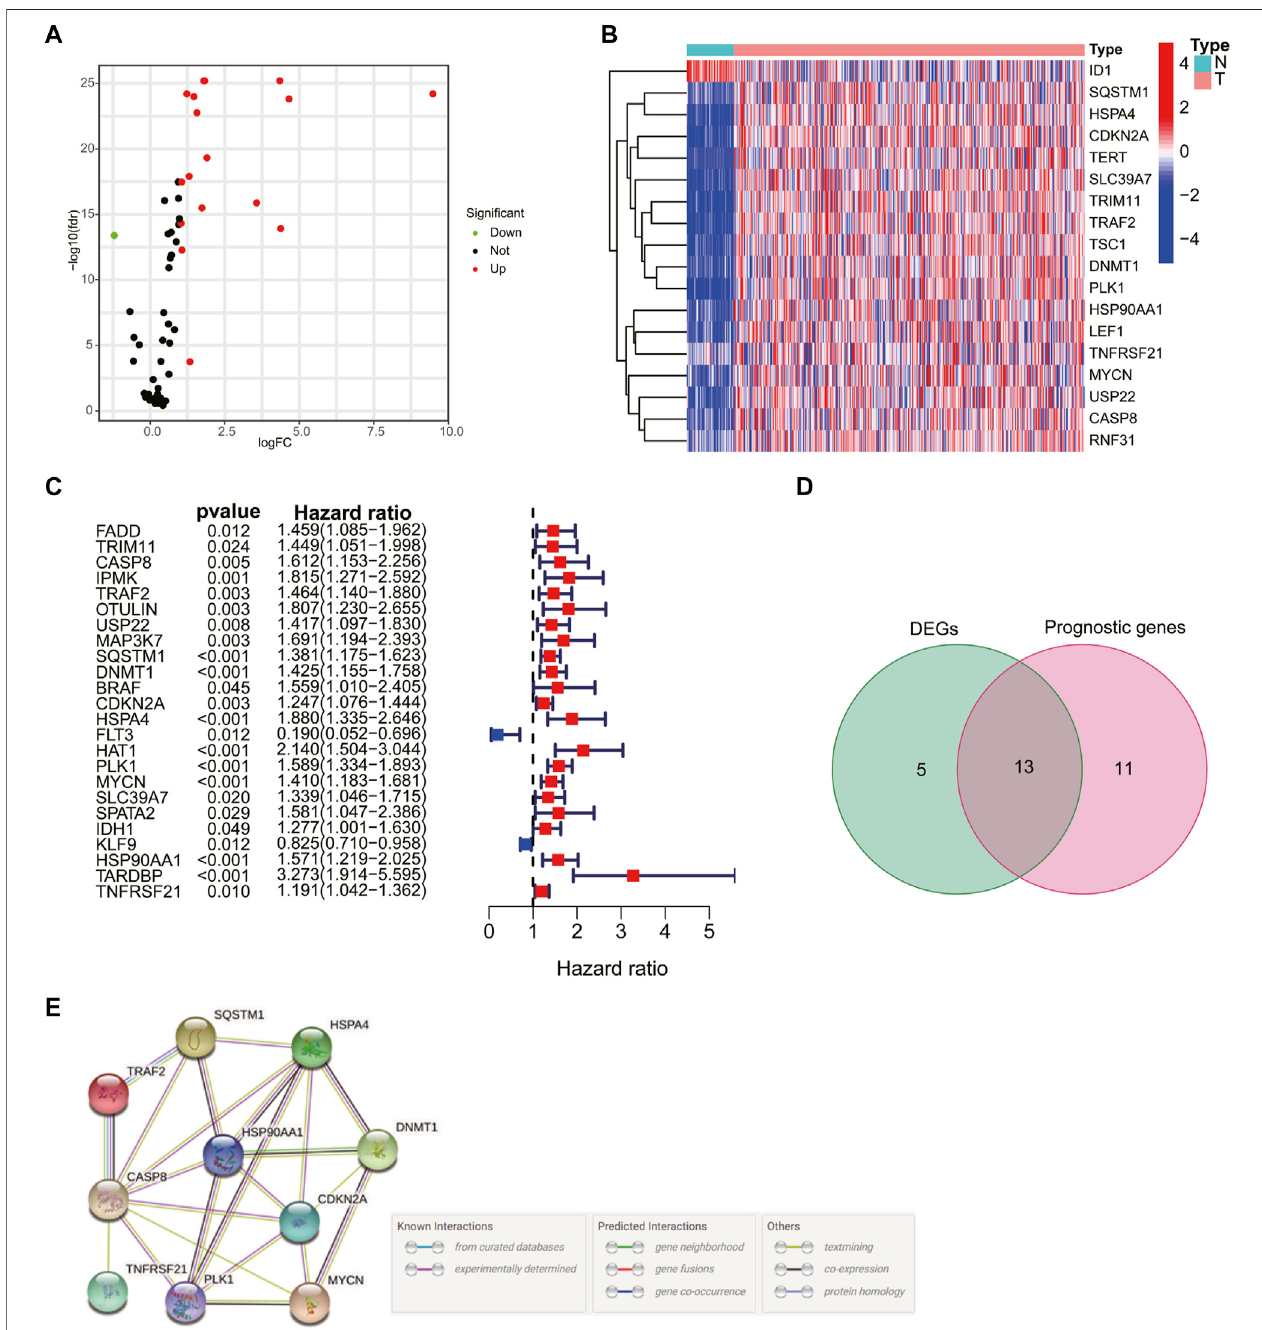
FIGURE 2 | Identi fi cation of prognosis-related genes in hepatocellular carcinoma (HCC) patients. Volcano plot (A) and heatmap (B) of 18 differentially expressed necroptosis-related genes (NRGs). (C) Univariate Cox regression analysis of prognosis-related genes. (D) Venn plot showing the 13 intersection genes. (E) Protein – protein interaction network of the interactions among intersection